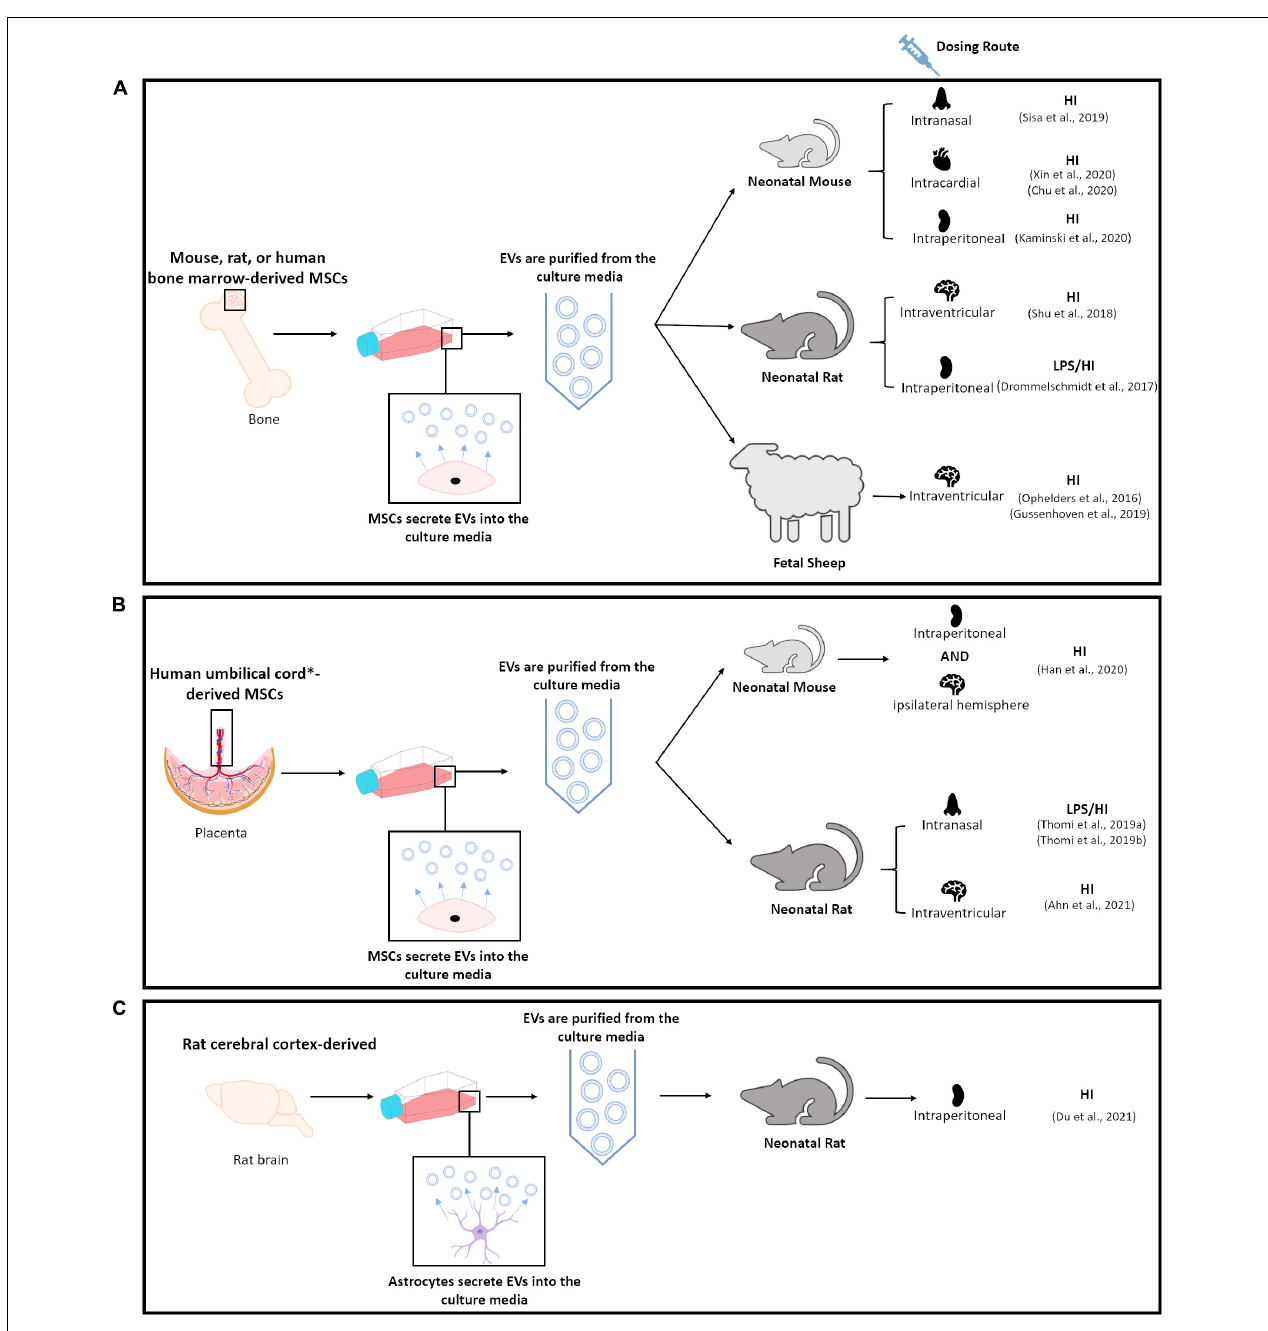
FIGURE 3 | Schematic diagram summarizing methodologies utilized in publications identified by this unbiased review of literature. (A) Highlights studies that utilized bone marrow-derived MSCs. (B) Highlights studies that utilized umbilical cord ∗ , umbilical cord blood ∗ or umbilical cord Wharton’s jelly derived MSCs. (C) Highlights study which utilized rat cortical-derived